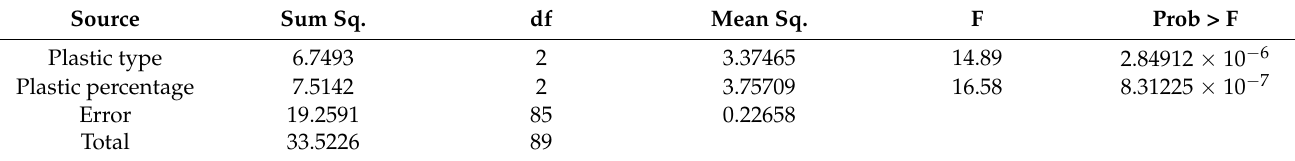
Table 4. The results of using ANOVA to verify the statistical significance of the impact of plastic type and plastic percentage on the maximum width of the damage zone on the drill entry side ( W 1 (mm)). Sum Sq. df Mean Sq.